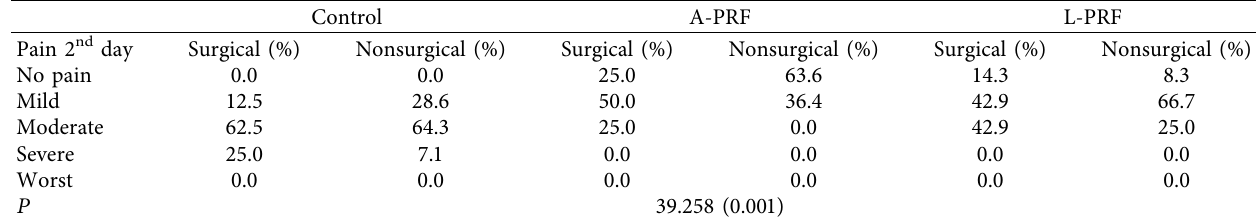
Table 2: The visual analogue scale pain scores of each group on the second day after tooth